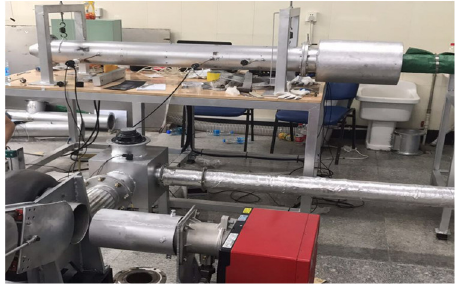
Figure 2. Cylindrical cavity fluid-solid coupling experimental platform.